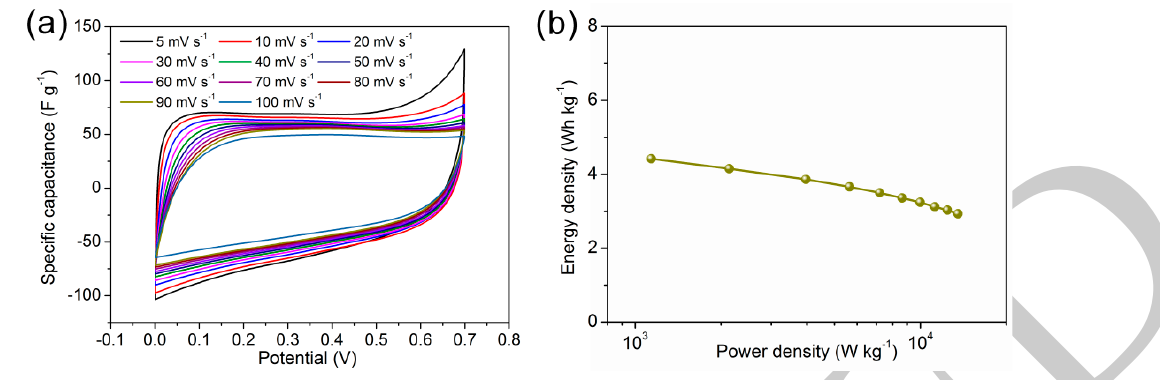
Figure 11. Electrochemical performance of the symmetric 20 h N-TiO 2 / TiN / Ti 3 C 2 T x // 20 h N-TiO 2 / TiN / Ti 3 C 2 T x supercapacitor in 1 M H 2 SO 4 . ( a ) CV profiles at di ff erent scan rates under the potential of 0.7 V. ( b ) Power density versus energy density plot of the symmetric supercapacitor by CV test.